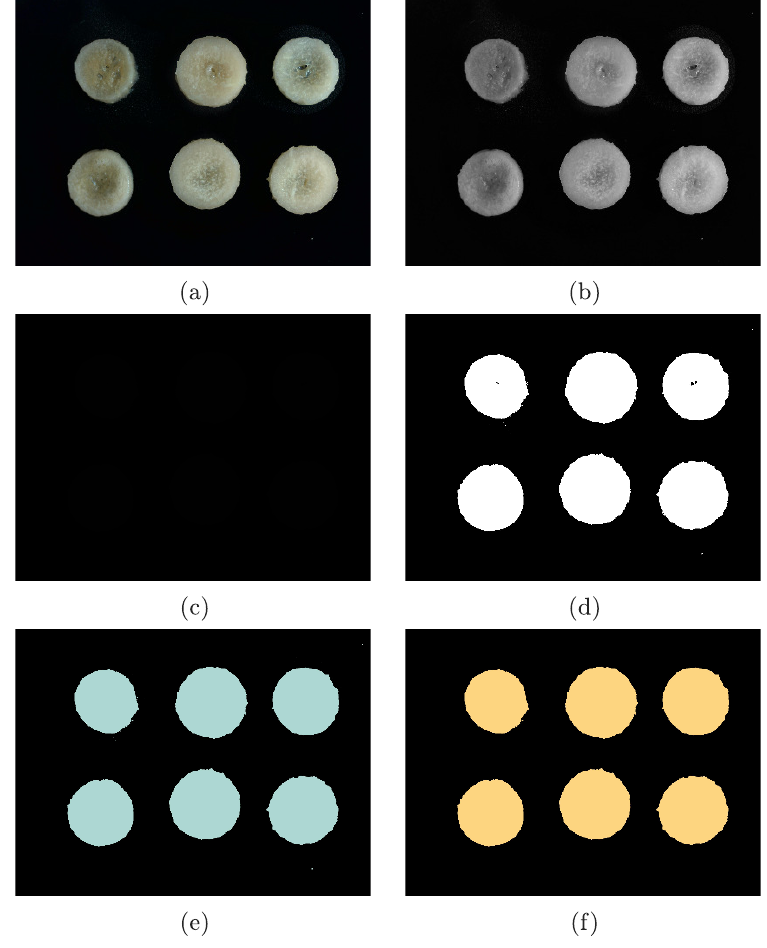
Figure 3. The steps of image processing: ( a ) original image; ( b ) grayscale image; ( c ) binary image; ( d ) converted black-and-white binary image; ( e ) image after filling holes; and ( f ) filtered